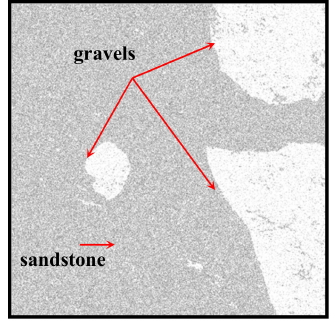
Figure 5. Sketch of the numerical